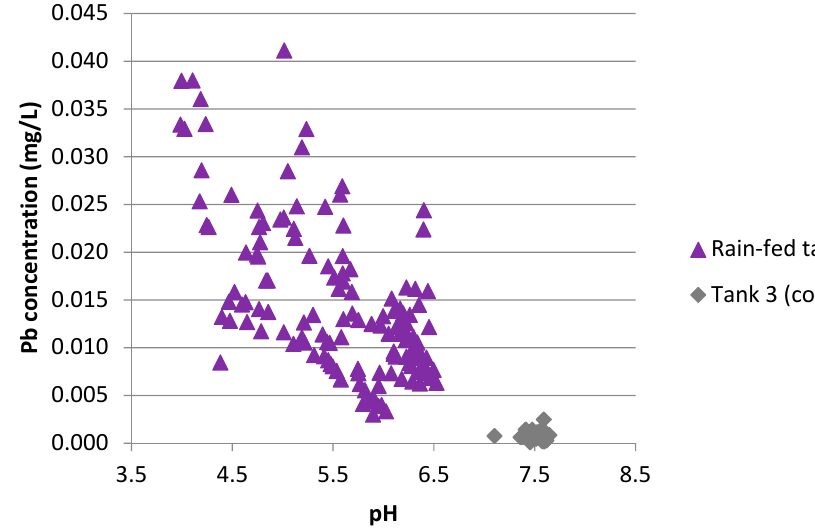
Figure 10. Relationship between pH and lead concentration for all samples.